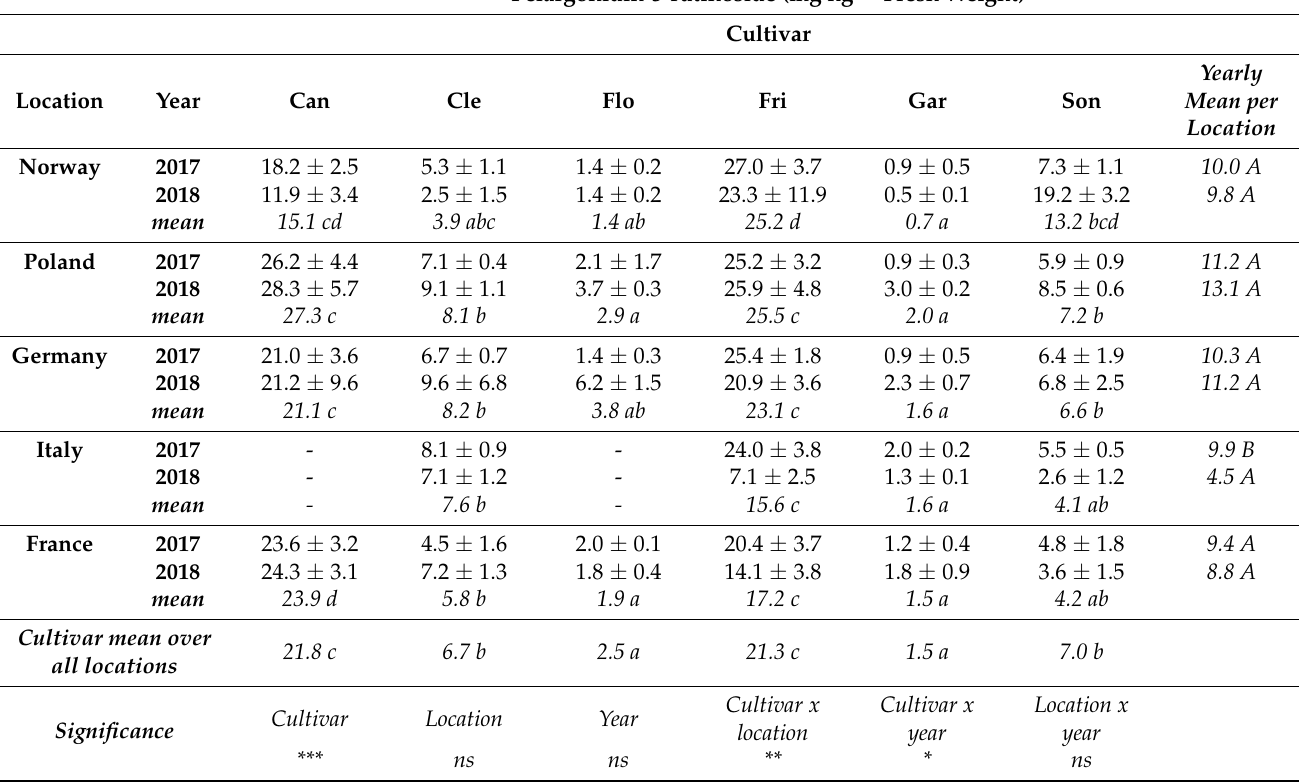
Table 5. Effect of growing location and year on pelargonidin-3-rutinoside content as the mean of two picking dates in fruits of six strawberry cultivars.